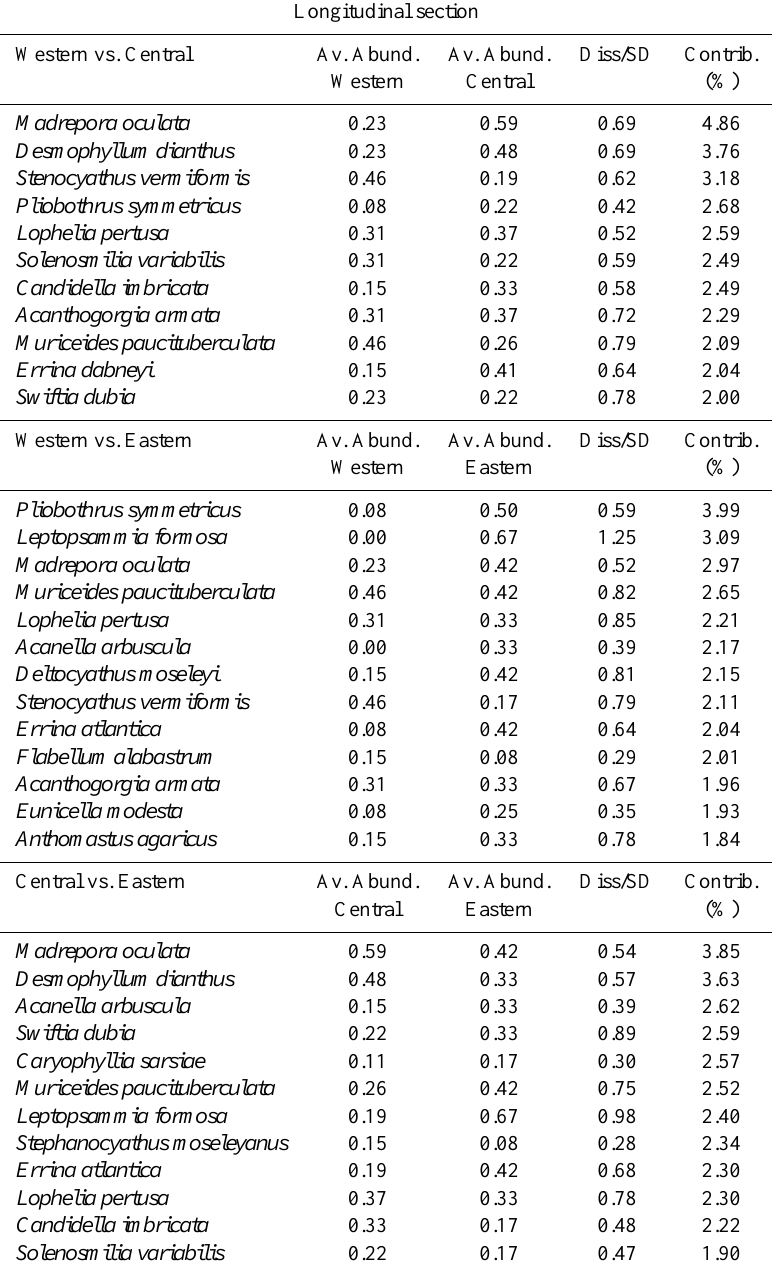
Table A2. Breakdown of average dissimilarity between groups tested into contributions from each species after SIMPER analysis. Species are ordered in decreasing contribution (cut-off cumulative value is 30%). Depth intervals: shallow (100–600m), intermediate (600–1000m) and deep (1000–1500m). Asterisks indicate species with high discriminating